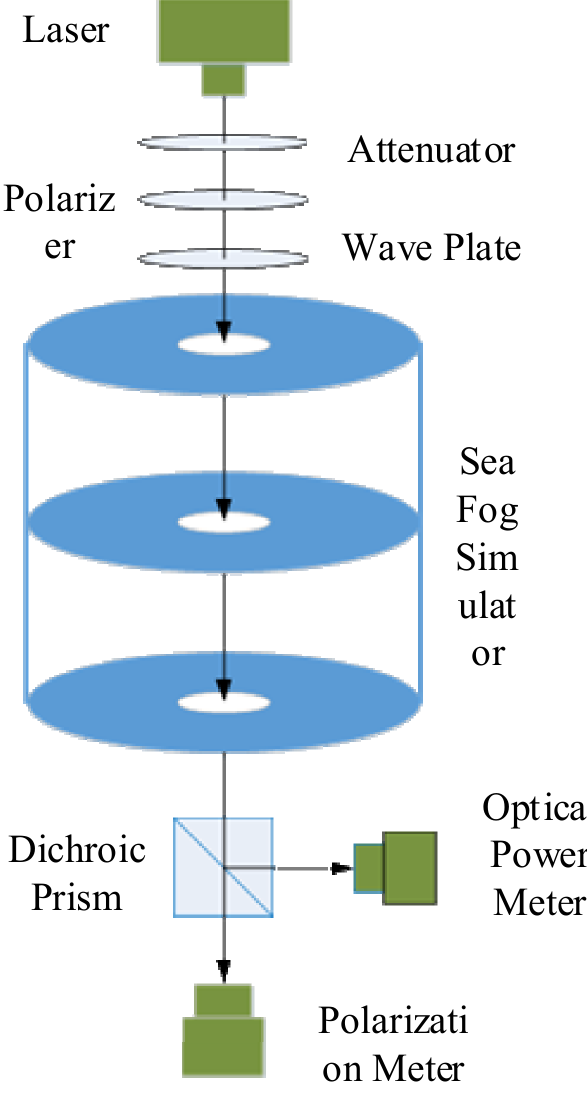
Figure 3. Schematic representation of the polarization transmission experiment.